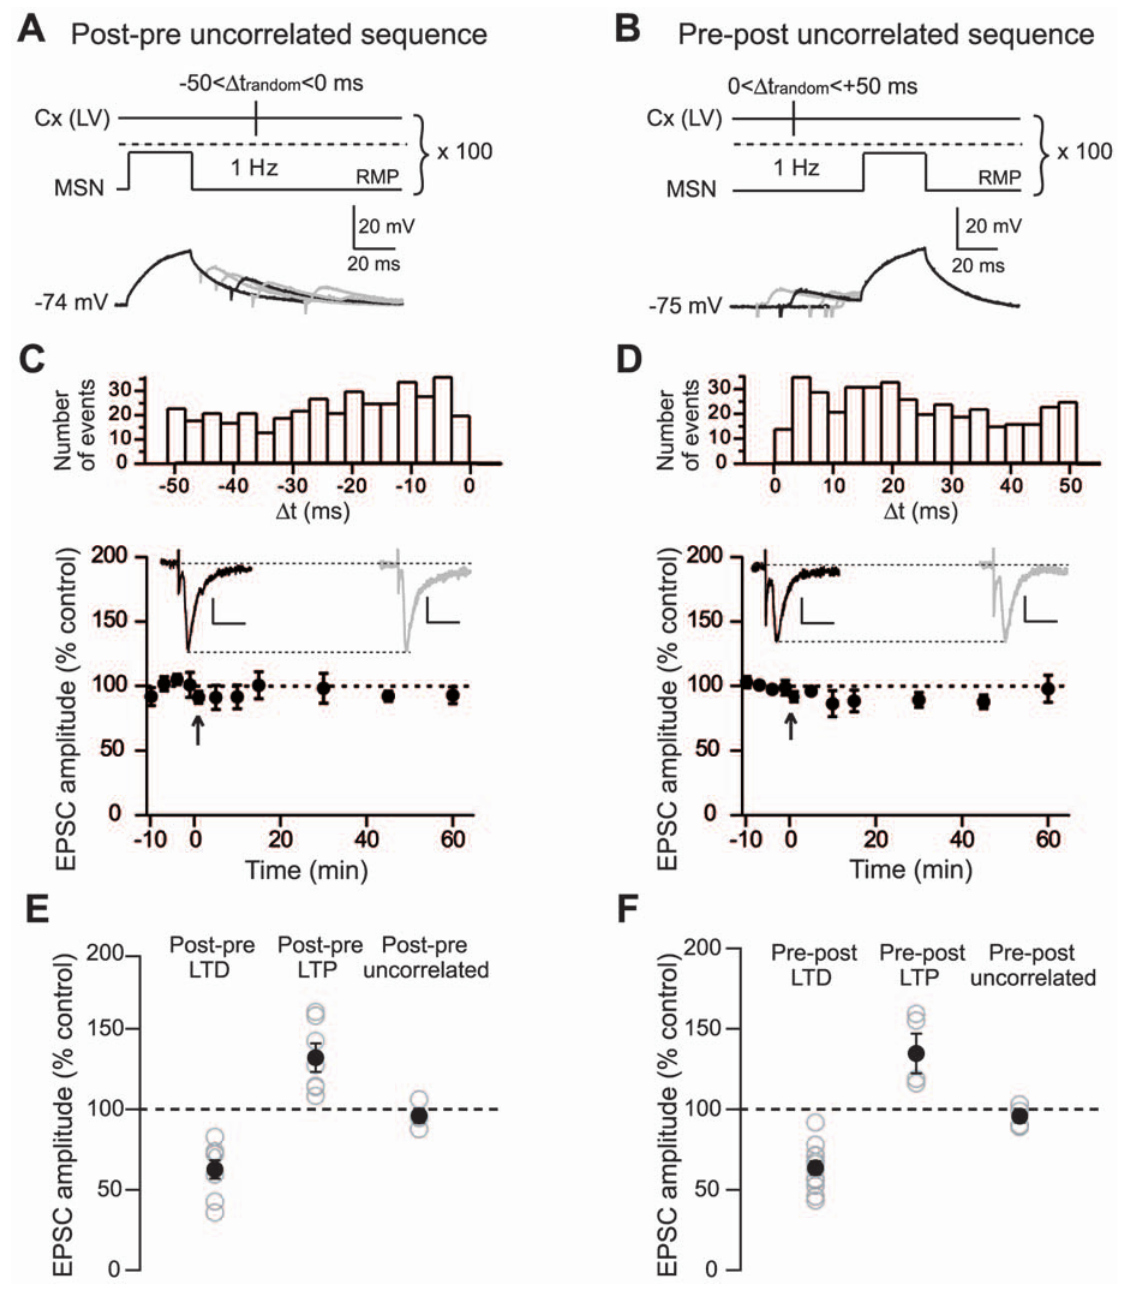
Figure 4. Uncorrelated random paired stimulations failed to induce significant long-term synaptic plasticity. ( A–B ) Uncorrelated post- pre (A) and pre-post (B) SDDP protocols consisted in varying randomly postsynaptic subthreshold depolarizations and presynaptic stimulations delays for each sweep of the pairing period D t random (range of random delays: 2 50 to 0 ms for post-pre sequences and 0 to + 50 ms for pre-post sequences). Below: examples of five consecutive postsynaptic MSN recordings (superimposed raw traces) during post-pre (A) and pre-post (B) random pairings. ( C–D ) Mean effect of pairing with random delays for post-pre (n=4 MSNs) (C) and for pre-post (n=4 MSNs) (D) sequences. An absence of long-term synaptic efficacy changes was observed in both groups (post-pre and pre-post random pairings). Insets: EPSCs evoked before (black traces) or 60 minutes after the uncorrelated sequences (grey traces). Scale bars are 50 pA and 20 ms. Arrows indicate the cellular conditioning protocol. Upper panels show the distribution of random pairing delays across all cells for uncorrelated post-pre ( 2 50 , D t random , 0 ms) (E) and pre- post (0 , D t random , + 50 ms) (F) SDDP sequences. ( E–F ) Long-term synaptic efficacy changes are illustrated for post-pre (E) and pre-post (F) correlated and uncorrelated paired SDDP. Open grey circles represent individual experiments and black circles represent average values. Post-pre ( 2 50 , D t random , 0 ms) or pre-post (0 , D t random , + 50 ms) uncorrelated paired stimulations did not induce significant long-term plasticity in contrast to correlated pairings.